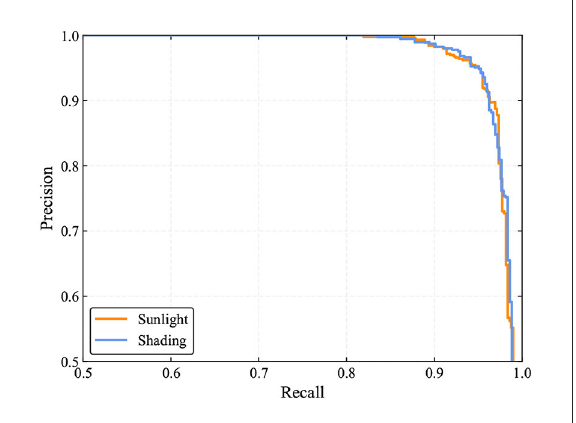
FIGURE11 PR curves of the proposed method under different lighting conditions.